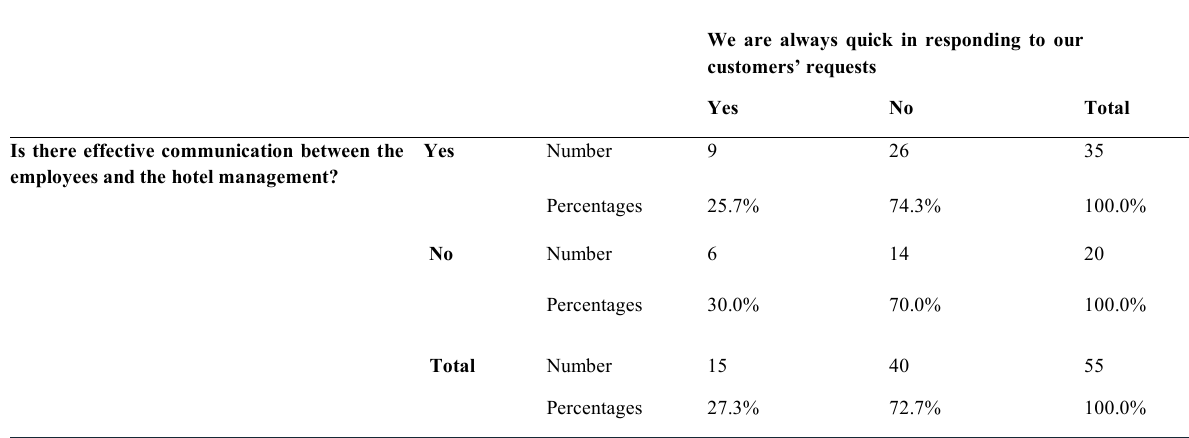
Table 2 : Relationship between Communication and Service